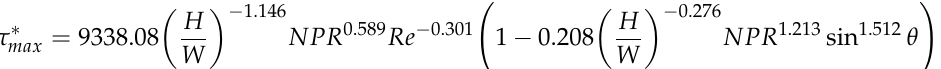
Figure 5. Predicted maximum normalized wall shear stress plotted against maximum normalized wall shear stress from CFD for normal impingement. Shade represents the nozzle pressure ratio, whereas the symbol represents the height-to-width ratio.